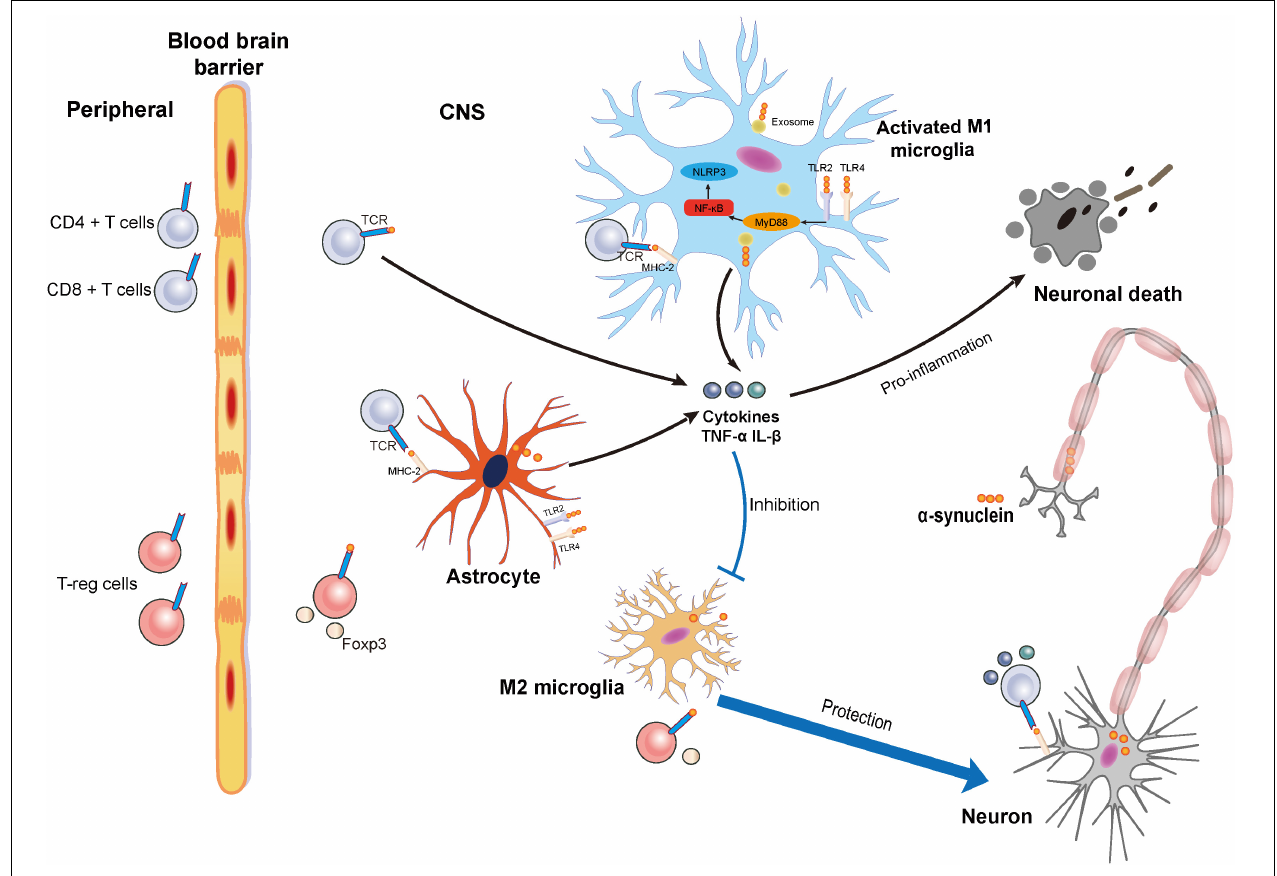
FIGURE 1 | Schematic illustration of neuronal death and protection induced by the activation of microglia via α -synuclein and the relationship between α -synuclein and T cells. Accumulated α -synuclein released from neurons binds the Toll-like receptor 2 (TLR2) or Toll-like receptor 4 (TLR4) to induce a proinflammation cascade. At the same time, nuclear factor-kappa B (NF- κ B) is activated to induce the MyD88 pathway for M1 microglia activation. α -synuclein can also be transferred into microglia by exosome. Proinflammatory cytokines such as tumor necrosis factor- α (TNF- α ) and interleukin-1 β (IL-1 β ) can be released from activated M1 microglia to result in neuronal death. Damage to the blood–brain barrier (BBB) in Parkinson’s disease (PD) results in the infiltration of T cells including cluster of differentiation 4 + (CD4 +) T cells, cluster of differentiation 4 + (CD8 +) T cells, and regulatory T cells from the peripheral blood that can infiltrate into central nervous system (CNS). In the CNS, microglia and astrocyte act as the antigen-presenting cells (APCs) to present the α -synuclein to the T cells. Activated CD4 + and CD8 + T cells release cytokines that promote neuronal death, while Tregs exert a protective effect on